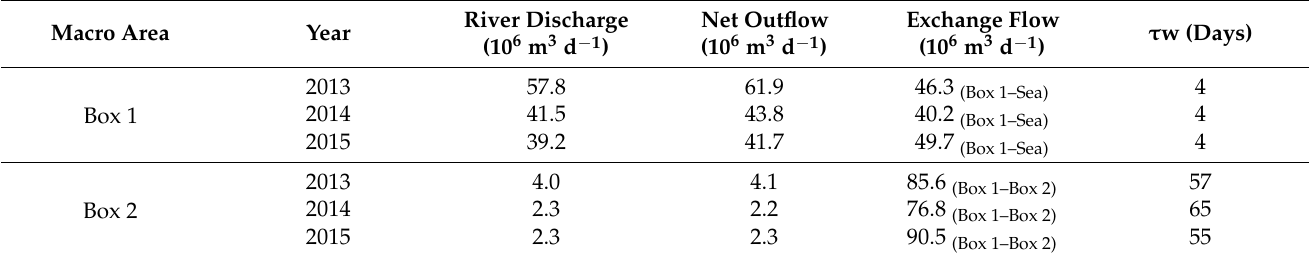
Table 1. Annual average river discharge and net outflow to the Baltic Sea, water volume exchange between Box 1 and the Baltic Sea (Box 1–Sea) and between Box 1 and Box 2 (Box 1–Box 2), and hydraulic residence time ( τ